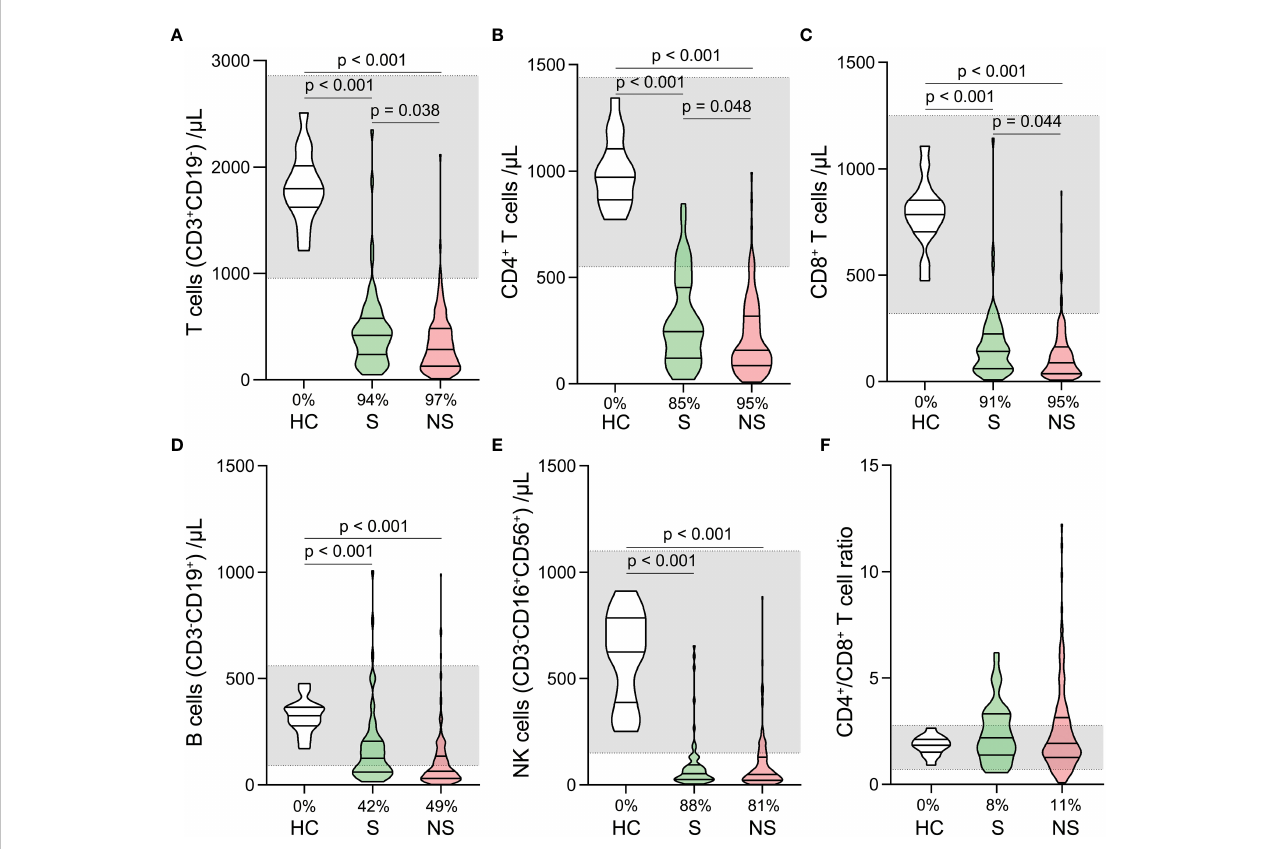
FIGURE 4 Changes of lymphocyte subset counts and CD4 + /CD8 + ratios in septic shock patients. The counts of T cells (A) , CD4 + T cells (B) , CD8 + T cells (C) , B cells (D) , Natural killer (NK) cells (E) , and CD4 + /CD8 + ratios (F) were compared among healthy controls, survivors, and nonsurvivors. The shaded region represents the normal value range. The proportions of patients whose test results are below the lower limit of the normal range are shown on the x-axis (A – F) .